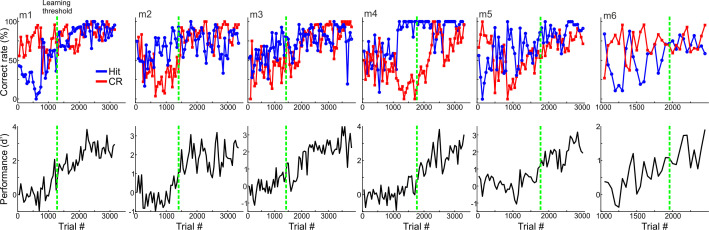
Behavioral performance and learning curves.Behavioral performance for all six mice, plotting the time course of Hit and CR rates in percent (top) and d’ (bottom) as a function of trial number. The learning threshold when mice reached d’=1 is indicated by vertical dashed green lines.